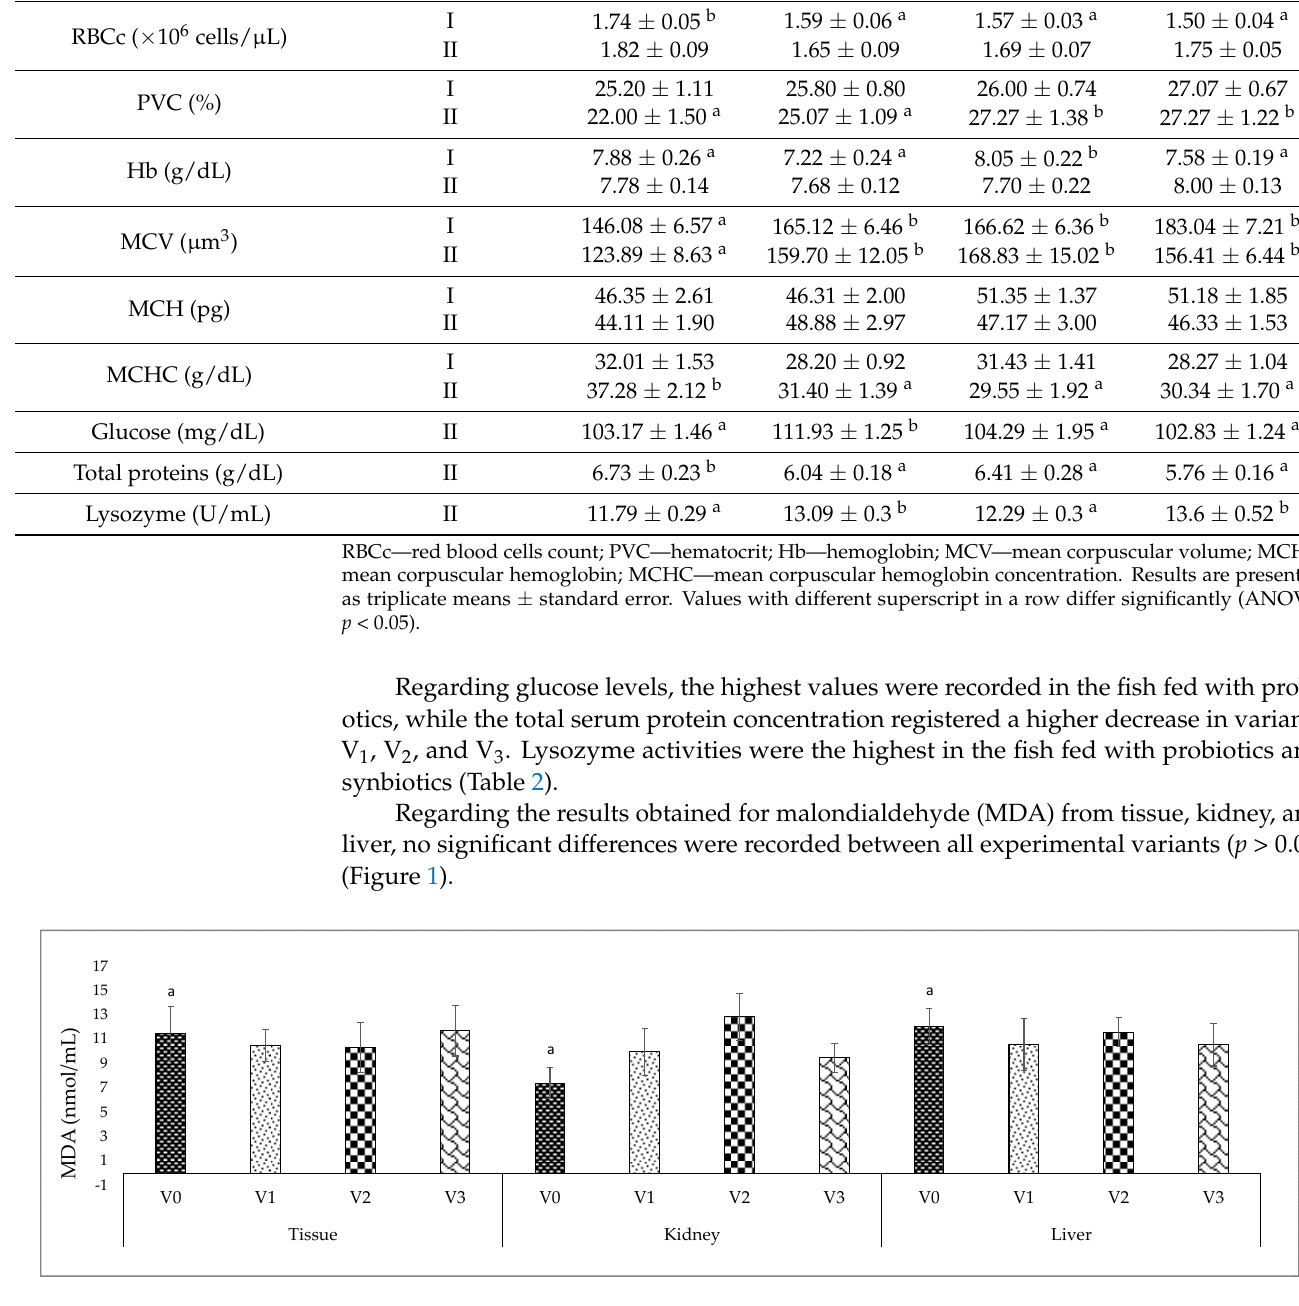
Figure 1. Variations of malondialdehyde in the tissue, kidney, and liver of the tilapia. Results are shown as mean values and standard errors. V 0 —control variant; V 1 —probiotic variant; V 2 —prebiotic variant; V 3 —synbiotic variant. The letter ”a” means that there were no significant differences ( p ˃ 0.05) .